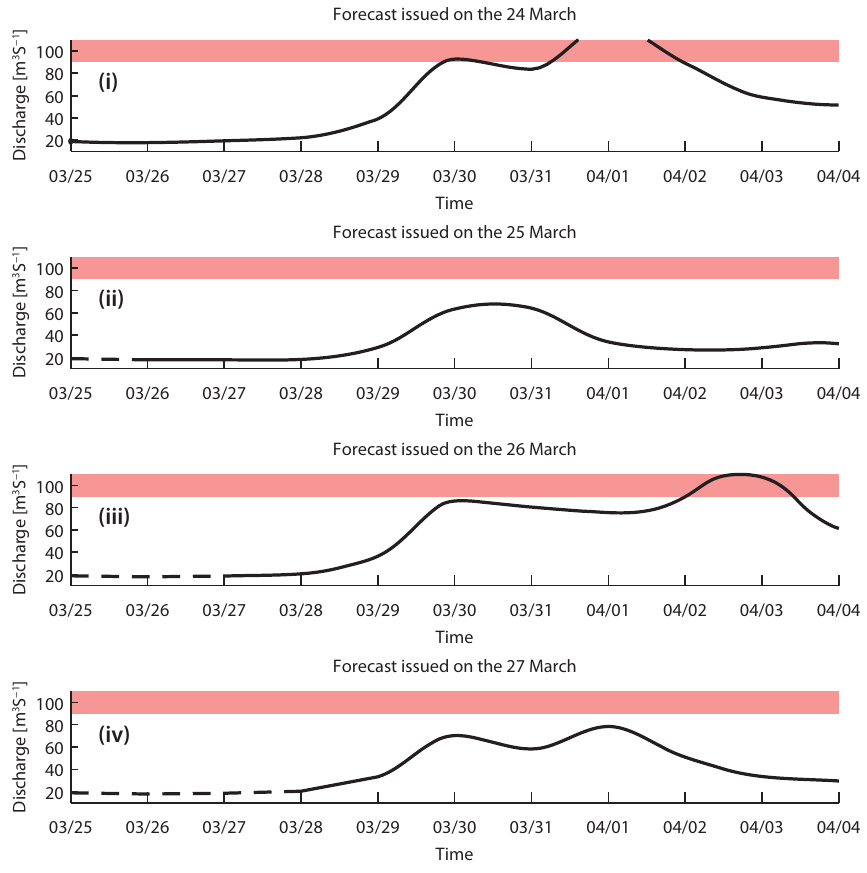
Fig. 1. Four different forecasts are shown issued on the (i) 24, (ii) 25,(iii) 26 and (iv) 27 March for a station along the river Severn (hypothetical case). The dashed line indicates the observations. The solid area represents a warning threshold. A flood alert would be issued in case (i) and